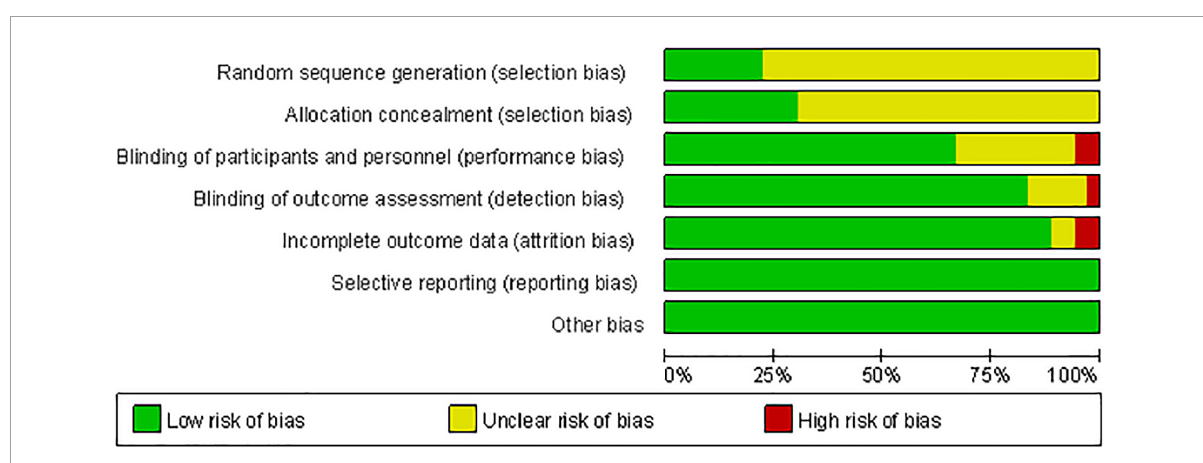
FIGURE3 Risk of bias graph presents the quality of included